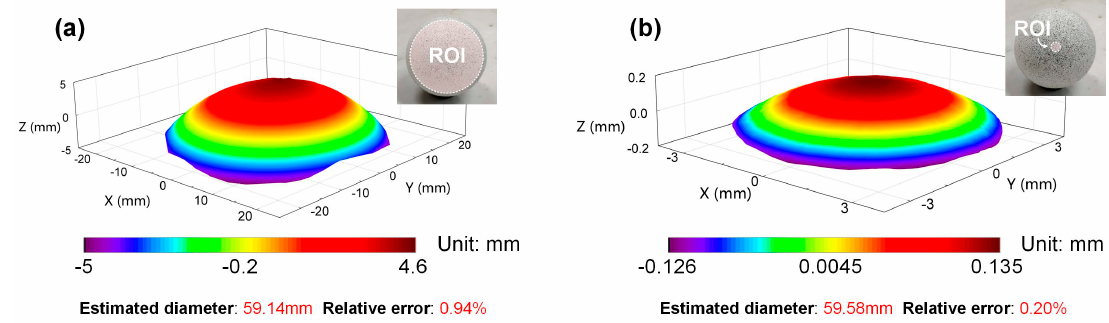
Figure 5. Reconstructed 3D shapes of the ball surface ( a ) using the regular stereo-DIC system, ( b ) using the microscopic stereo-DIC system.